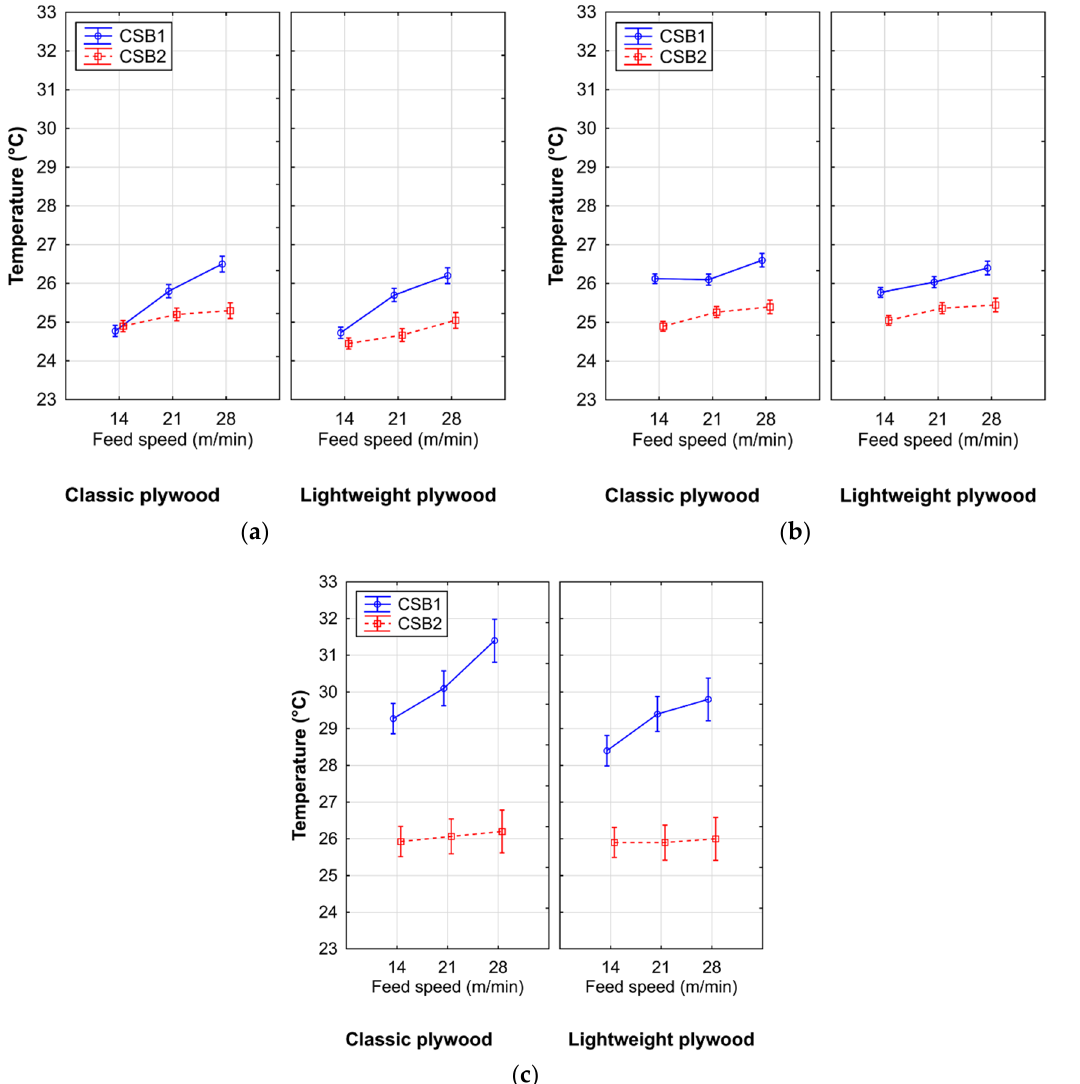
Figure 9. Dependence between the surface temperature of the circular saw blades and the feed speed